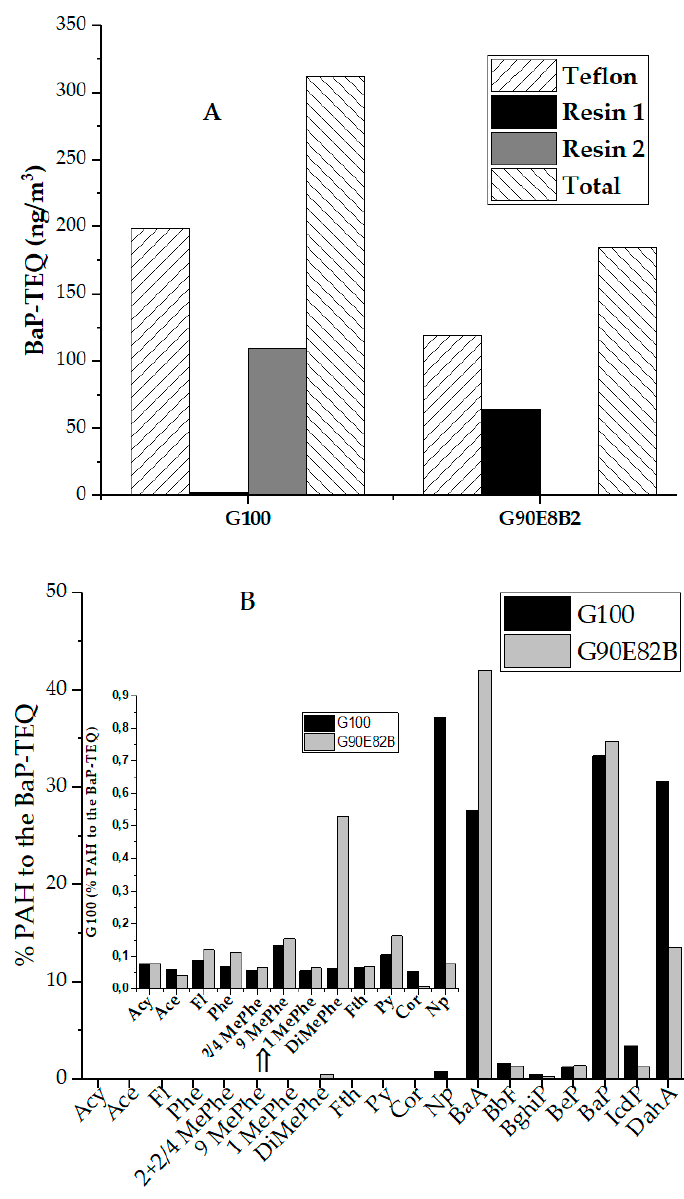
Figure 5. ( A ): Benzo(a)pyrene (BaP)-TEQ (ng / m 3 ) as a function of the fuel for each individual trap systems. ( B ): percentage of contribution of each individual PAH to the BaP-TEQ for each fuel.